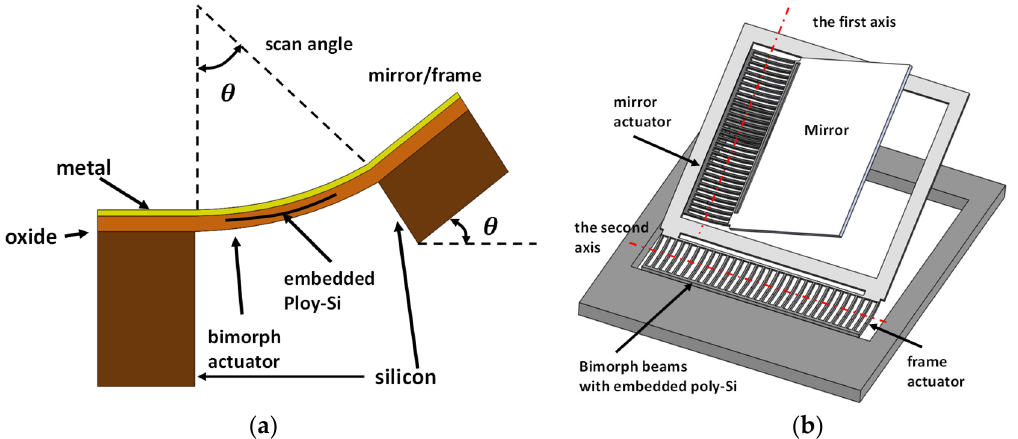
Figure 6. Schematics of ( a ) the working principles of bimorph structures [44]; ( b ) the 2D MEMS scanner using two axial bimorph beams to drive the frame and the mirror [45].